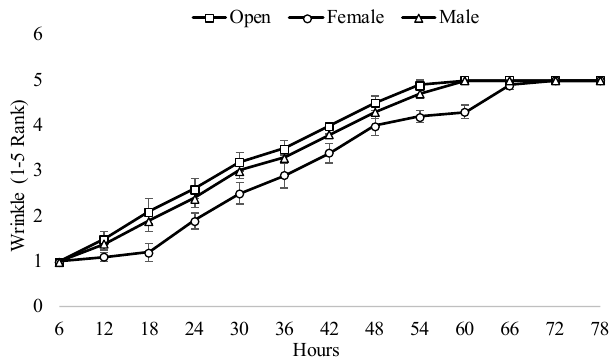
Fig 4 . The increase in fruit wrinkling with successive post-harvest observation in case of open, female and male pollination